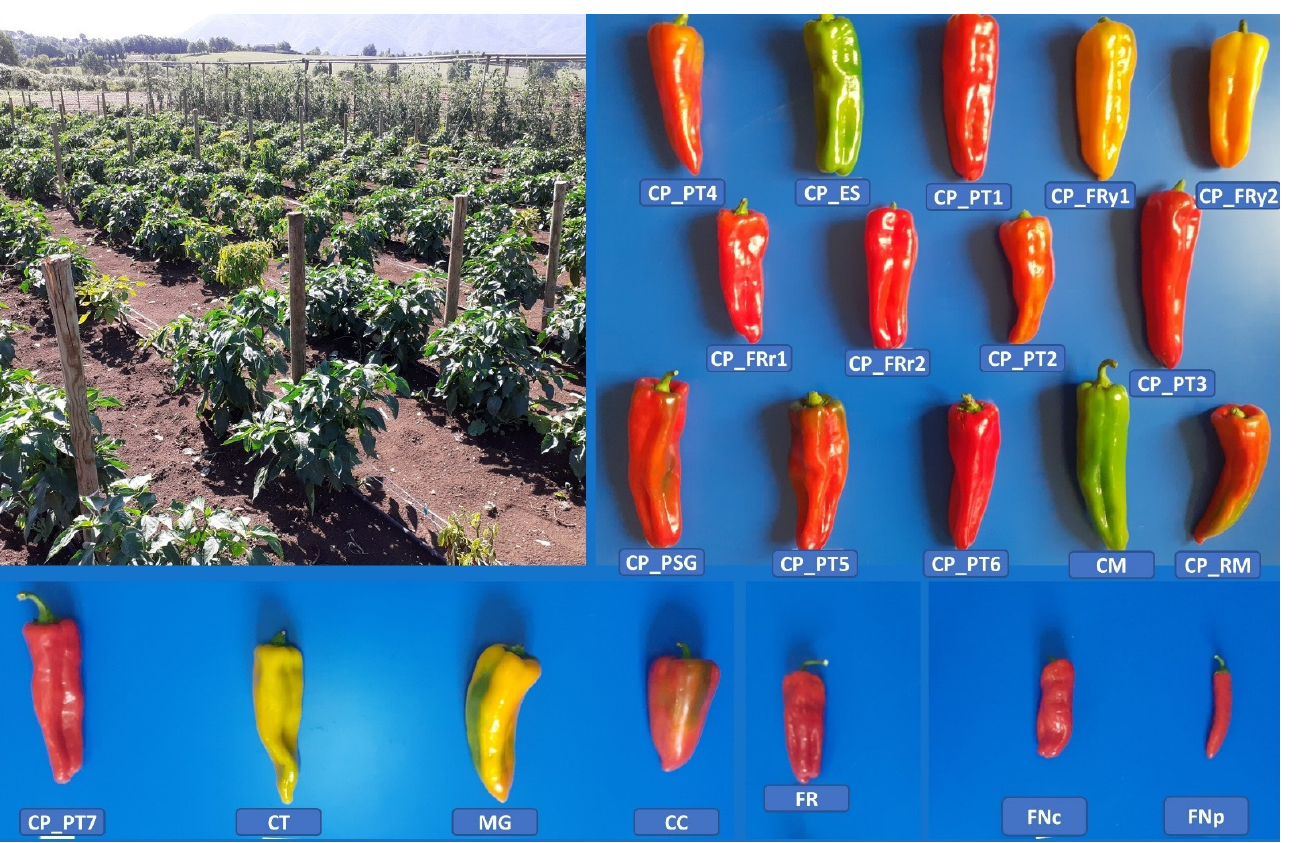
Figure 1. Details of the experimental field trial in Alvito (Frosinone, 41°41 ′ N 13°44 ′ E) and morphological diversity of the ‘Peperone Cornetto di Pontecorvo’ accessions (CP) and similar types. Additional details are in Table 1.